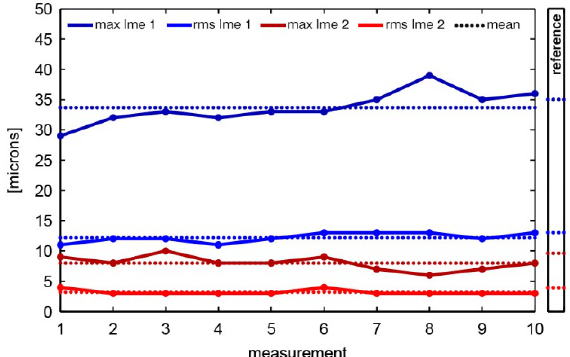
Figure 12. Quality characteristics (distance-dependent distortion) Figure 14. Quality characteristics (usage of all colour channels)